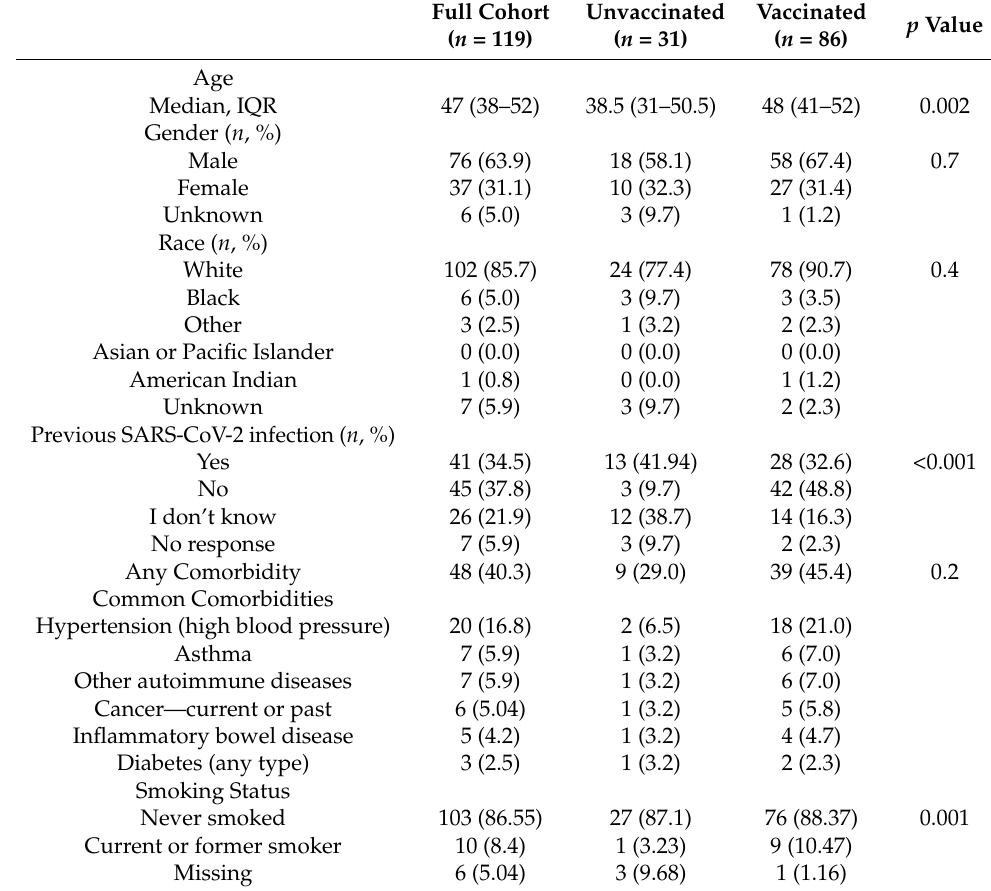
Table 1. Cohort demographics by vaccination